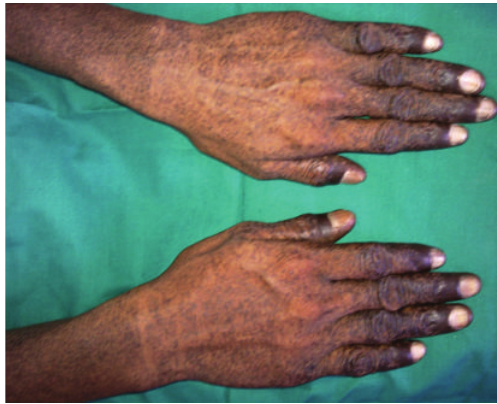
Figure 2: Photographs showing dark mottled pigmentation on the hands.